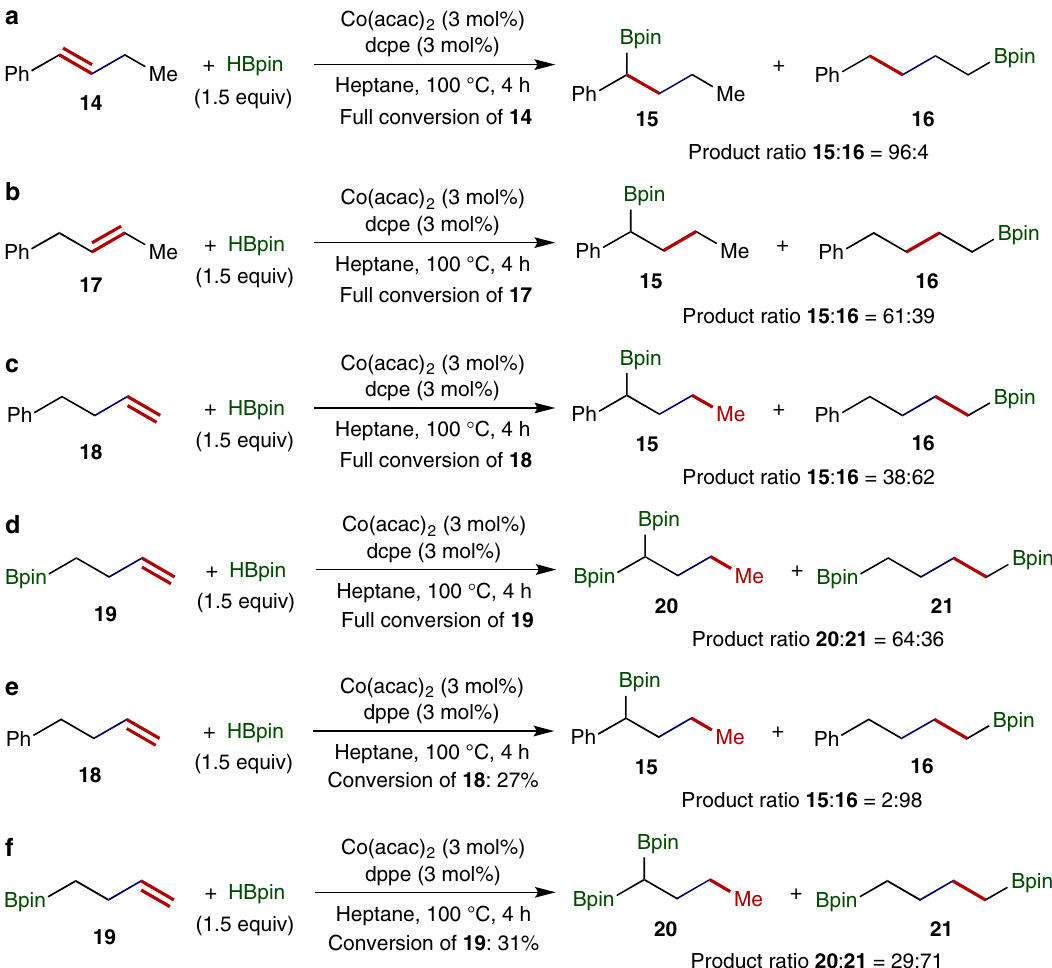
Fig. 7 Chaining-walking hydroboration of phenyl- and boryl-containing alkenes. a Hydroboration of alkene 14 . b Hydroboration of alkene 17 . c Hydroboration of alkene 18 . d Hydroboration of alkene 19 . e Hydroboration of alkene 18 catalyzed by Co(acac) 2 /dppe. f Hydroboration of alkene 19 catalyzed by Co(acac) 2